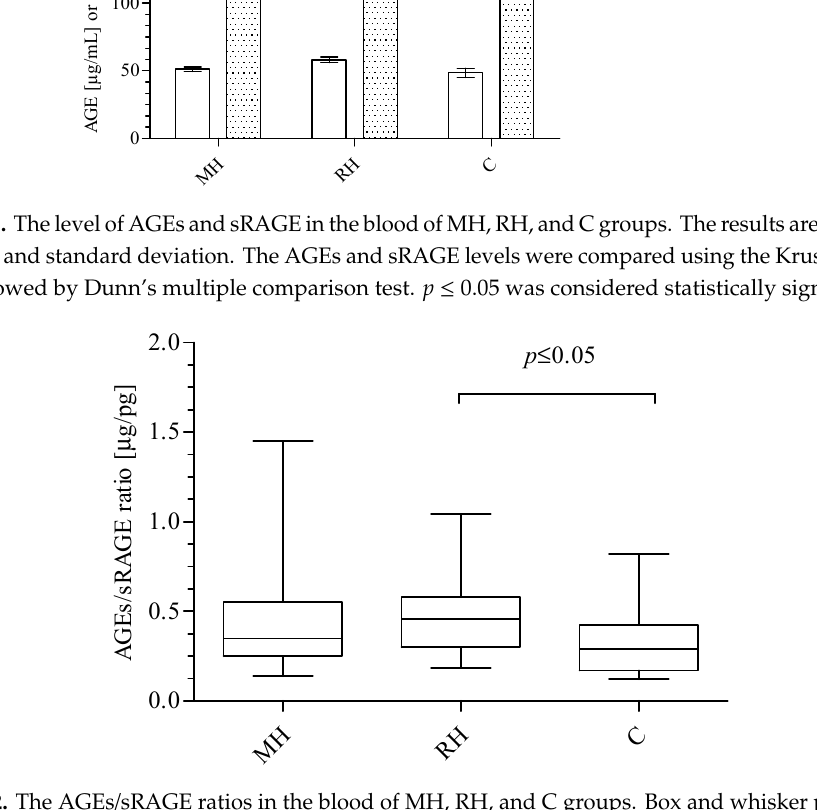
Figure 2. The AGEs / sRAGE ratios in the blood of MH, RH, and C groups. Box and whisker plots show median (central line), upper and lower quartiles (box) and range excluding outliers (whiskers). Data were analyzed using the Kruskal-Wallis test followed by the Dunn’s multiple comparison test. p ≤ 0.05 was considered statistically significant.